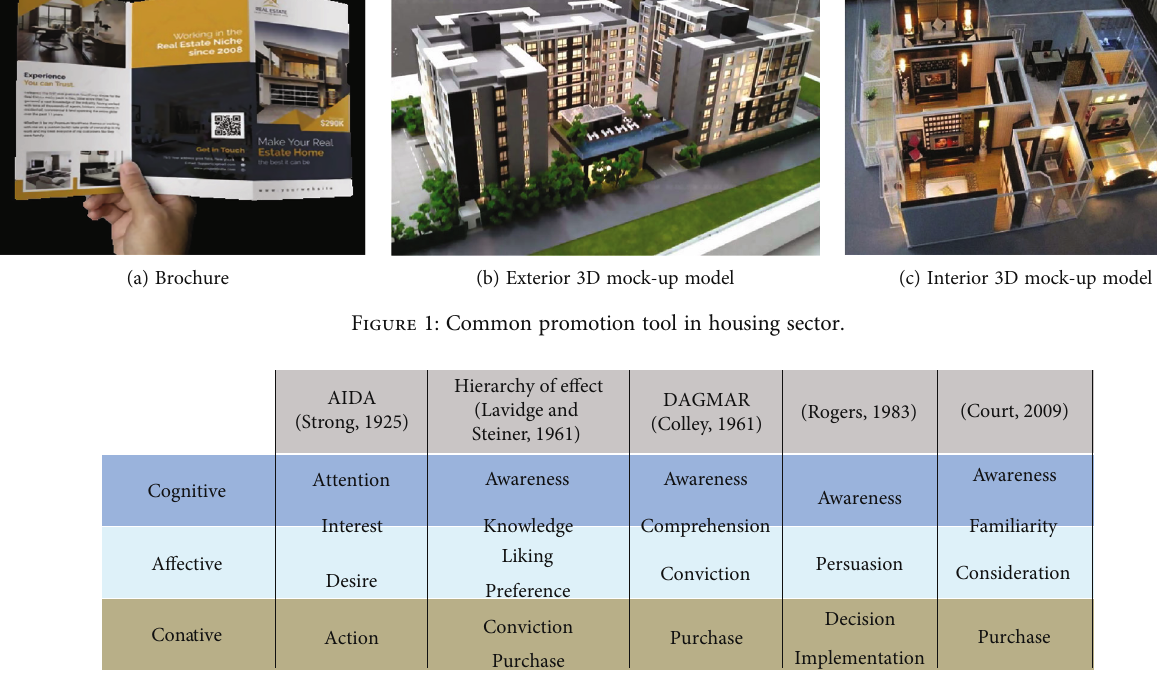
Figure 2: Summary of response hierarchy model based on C-A-C